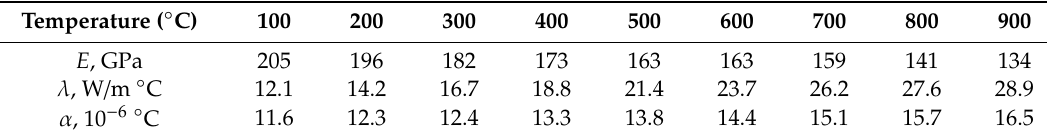
Table 3. Variation characteristics of three nonlinear